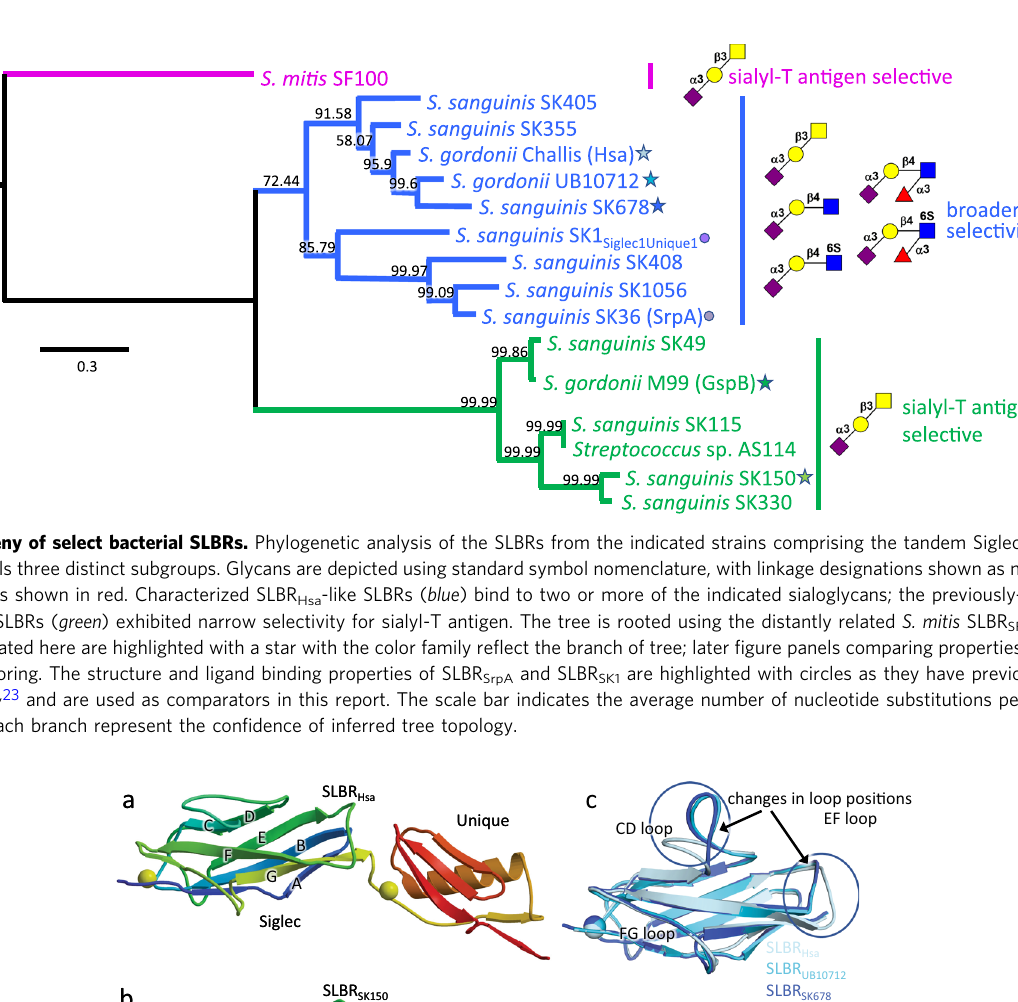
Table 3). For SLBR Hsa , this included structures from crystals soaked with the high-af fi nity ligands sTa (Figs. 1a, 4a, and